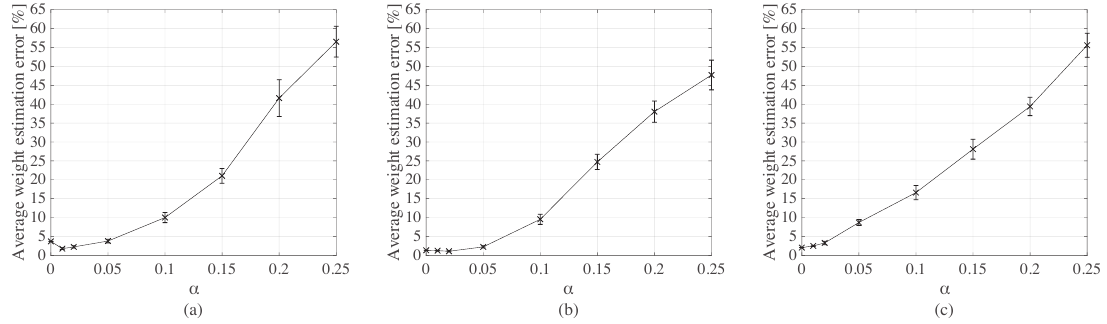
Figure 10. Mean weight estimation error (with +/- standard deviation intervals) as functions of noise level for: ( a ) type 1 truck; ( b ) type 2 truck; and ( c ) type 3 truck.